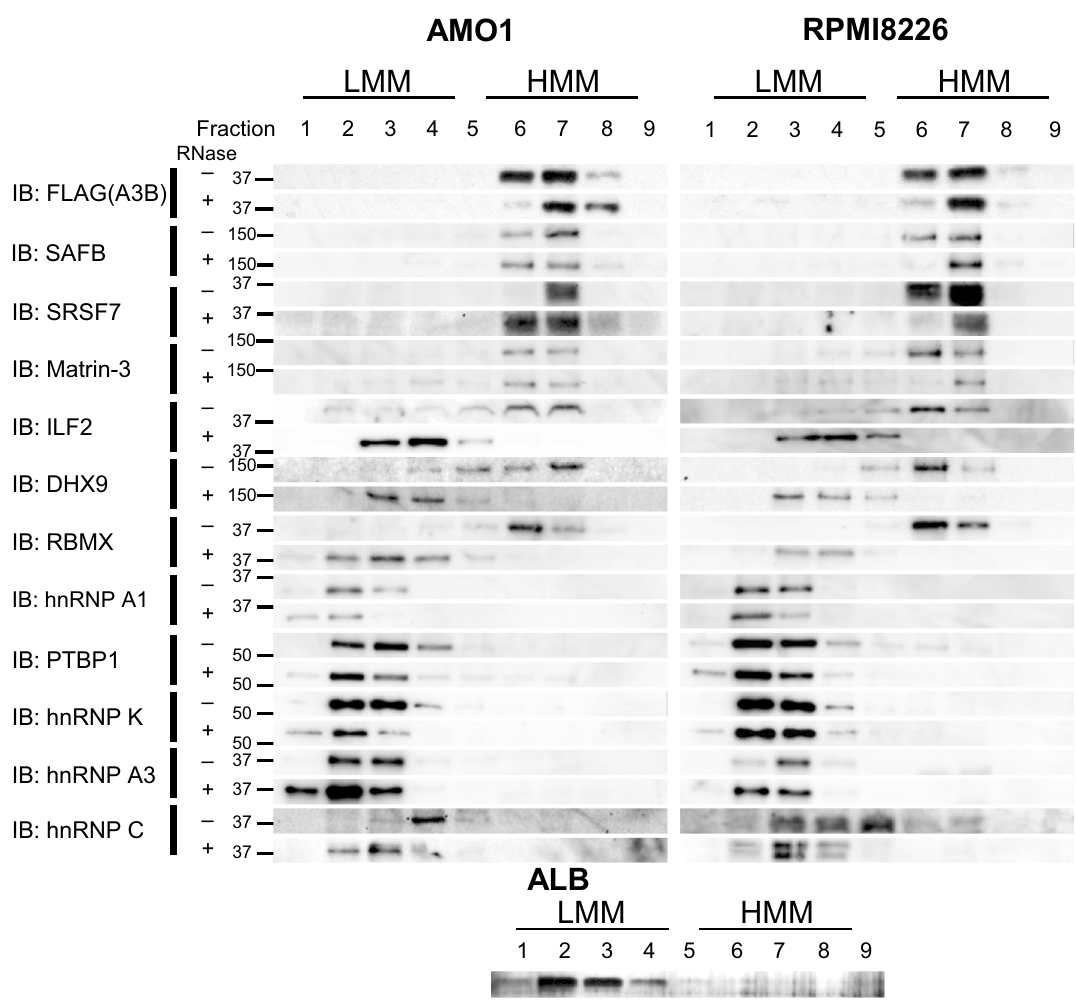
Figure 3. Density gradient sedimentation analysis showing that ILF2 is a component of HMM complexes. Whole cell lysates from AMO1 KI and RPMI8226 KI or lysis buffer containing albumin were loaded on to a discontinuous OptiPrep gradient (4 36%) and centrifuged at 25,000 rpm for 14 h at 4 °C. The separated fractions were analysed by Western blotting with specific antibodies against FLAG and each interactor candidate ( left , AMO1, right , RPMI8226). The position of albumin as a molecular weight marker was confirmed using silver staining. LMM Low molecular mass. HMM High molecular mass. Original blots are presented in Supplementary Figure